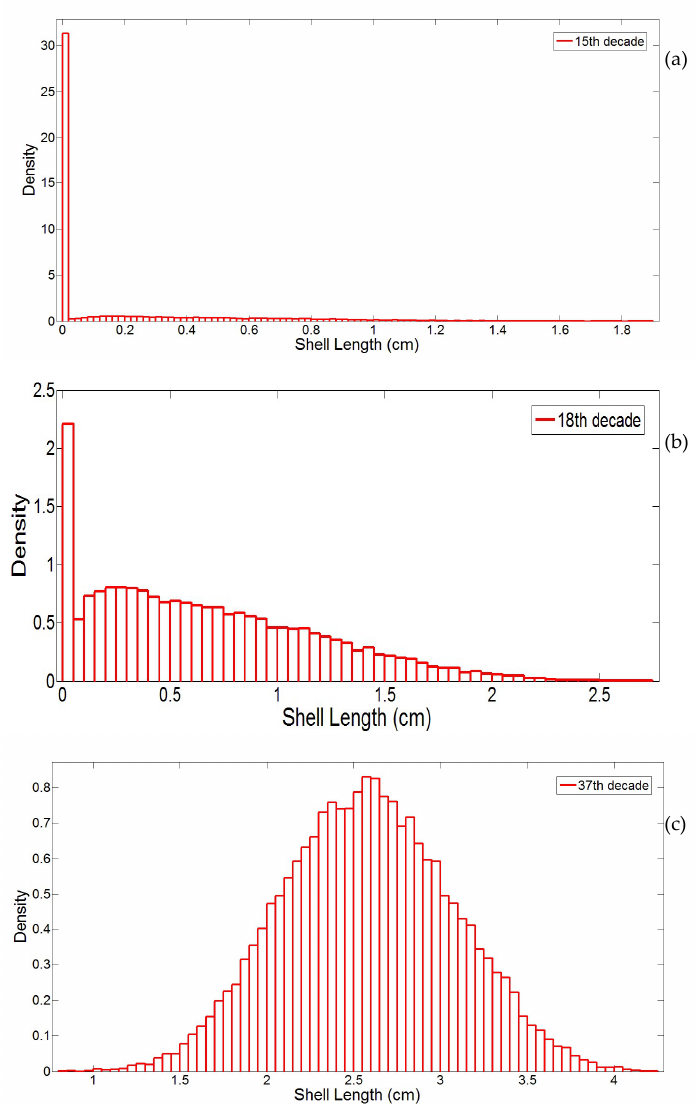
Figure 14. Evolution of shell length distribution as a function of time for three selected 10 day periods: ( a ) 15th, ( b ) 18th, ( c )